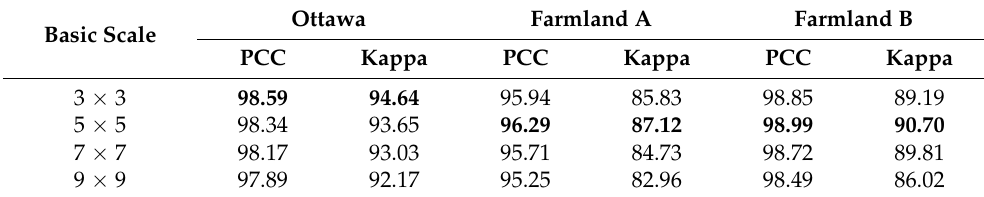
Table 6. Sensitivity analysis of the HVANet in relation to patch size.